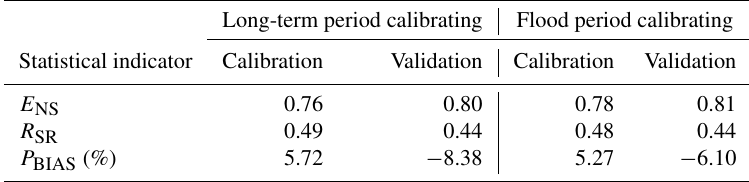
Table 5. SWAT model performance statistics for long-term period calibrating and flood period